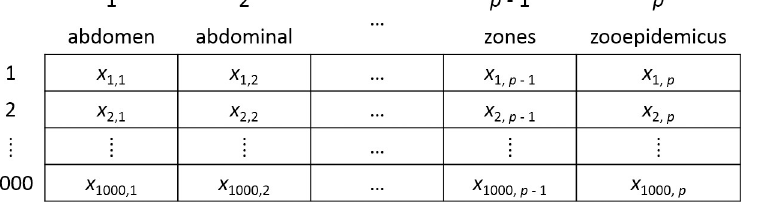
Fig 2. Document term matrix. After all documents were tokenized, the results were summarized in a document term matrix (DTM). There were p unique words extracted in the tokenization process, with several examples shown. Each row represents a document, and each column represents a word. Entry x ij in row i , column j represents the term frequency–inverse document frequency (TF-IDF) for the j -th term in the i -th document. The DTM is a sparse matrix in which most entries are